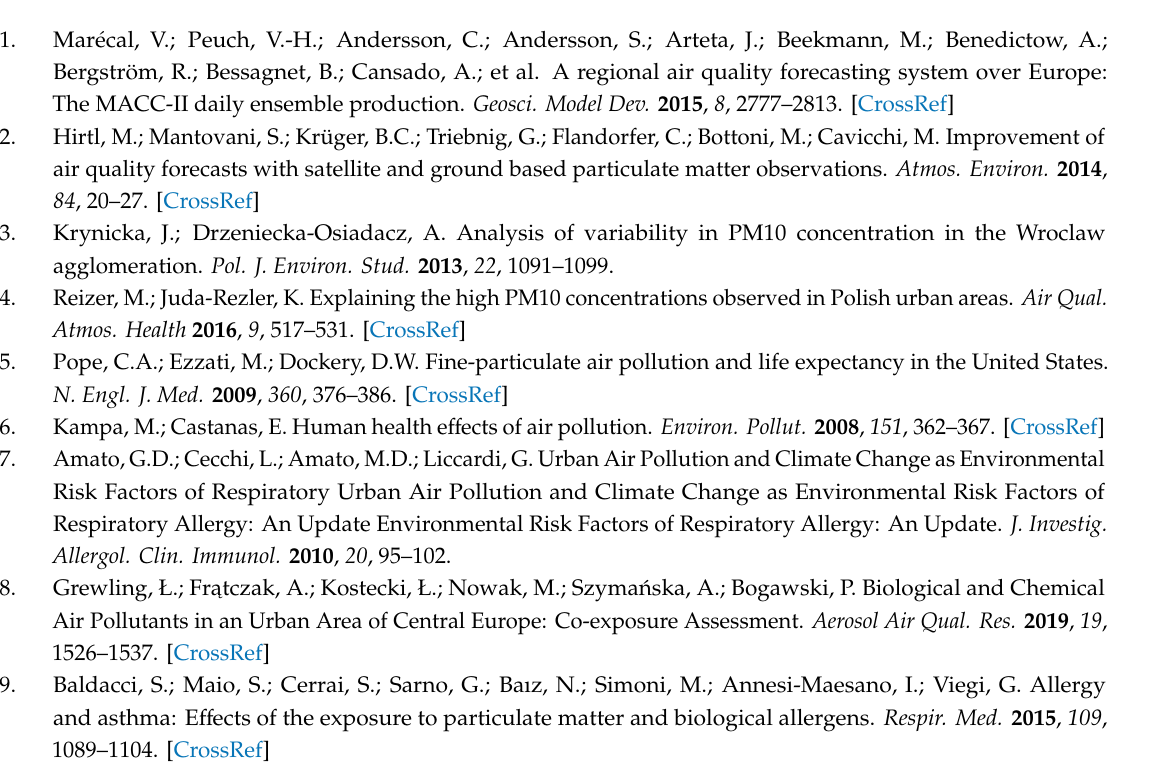
Figure S1: Performance diagram summarizing the success ratio, probability of detection, bias (dashed lines with labels on the outward extension of the line) and critical success ratio (solid lines) for detecting PM2.5 concentrations above 61 µ g m -3 (“poor” air quality) by the BASE, SURF, MODIS and SM simulations over Poland for the winter 2017 episode over Poland. The perfect model lies in the upper right corner, Figure S2: Spatial distributions of MGE for PM2.5 concentrations for the winter 2017 episode over Poland., Figure S3: Spatial distributions of FAC2 for PM2.5 concentrations for the winter 2017 episode over Poland., Figure S4: Spatial distributions of R for PM2.5 concentrations for the winter 2017 episode over Poland., Figure S5: Spatial distributions of MGE for PM2.5 concentrations for the summer 2015 episode over Poland., Figure S6: Spatial distributions of FAC2 for PM2.5 concentrations for the summer 2015 episode over Poland., Figure S7: Spatial distributions of R for PM2.5 concentrations for the summer 2015 episode over